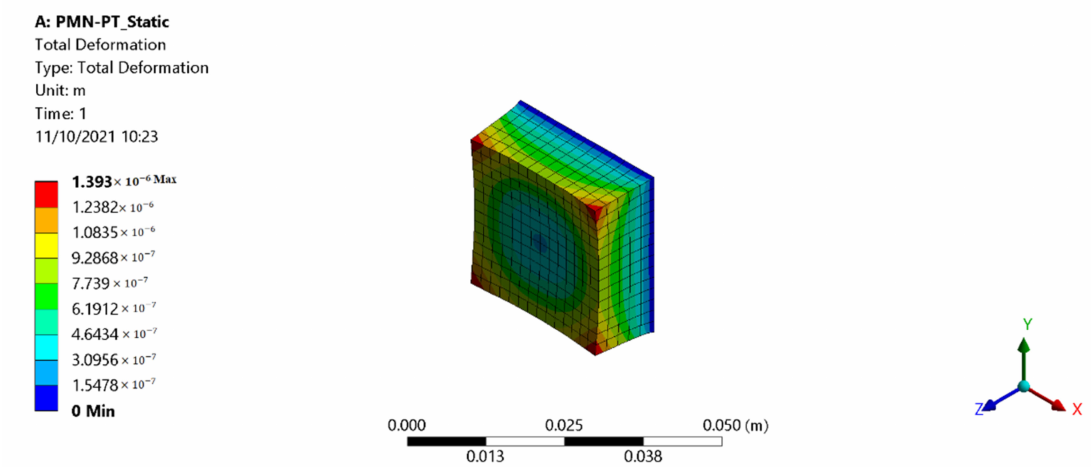
Figure 5. PMN-28% PT plate static analysis result using Method 2.